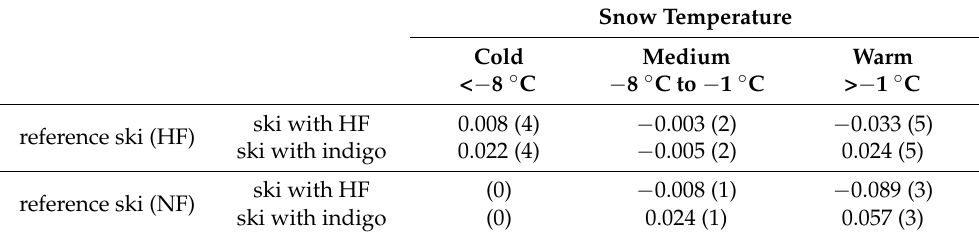
Figure 5. Scanning electron microscopy images showing the roughened surface of the ultra-high- molecular-weight polyethylene (UHMWPE) base before ( A ) and after coating with E-indigo ( B ). The scale bar is 100 µ m (52 ◦ tilt view) [68]. Table 2. Relative time differences per second of running time (diff/s) of comparative field tests with calibrated cross-country skis and different snow temperatures (in parentheses: number of tests with 6 runs each; HF = high fluor and fluor powder, NF = non-fluorinated wax). The mean value at a snow temperature below − 8 ◦ C was determined from 4 test series of 4 measurements each. The more negative the value, the smaller the friction